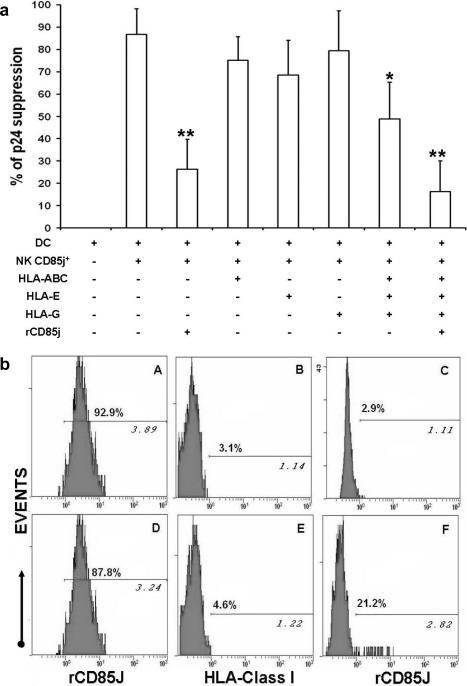
Involvement of NK CD85j receptor interaction with CD85j/ligands, including non-HLA class I ligands, in the control of HIV-1 replication in MDDC.(a) MDDC were infected with HIVBal and incubated with CD85j+ NK cells after blocking CD85j receptor interactions with HLA class I molecules on the MDDC by treatment with Mabs to HLA class I ABC (HLA-ABC), E (HLA-E) or G (HLA-G) or by incubating MDDC with a recombinant CD85j protein (rCD85j). Blocking reagents were also added during coculture. MDDC infection was evaluated by measuring p24 in the supernatants 10 days later. The results are expressed as the percentage suppression of p24 (mean+SE) in comparison with HIVBal-infected MDDC not exposed to NK cells in 8 independent experiments. Significant differences in the levels of p24 suppression after incubation with the three anti-HLA class I Abs, with rCD85j or with rCD8j more the three anti-HLA class I Abs in comparison to CD85j+ NK cells cultured with infected DC without Abs are indicated by asterisks: * p<0.05, **p<0.001 (b) Flow cytometric analysis of rCD85j binding to uninfected MDDC (top panels) or to HIVBal-infected MDDC (bottom panels). MDDC staining with rCD85j as revealed by anti-hIgG-PE Abs (A and D). MDDC staining with a mix of anti-HLA Class I-PE mAbs after incubation with rCD85j (B and E), or with rCD85j and anti-hIgG-PE Abs after incubation with a mix of anti-HLA Class I MAbs. A representative experiment of three is shown. Without rCD85j blockade, nearly all MDDC were stained by anti-HLA-PE (not shown). The concentrations of anti-HLA class I Abs used in blocking experiments (10 µg/ml of each anti-HLA class I A,B,C, E and G) totally prevented the detection of HLA class I molecules on MDDC by using labelled anti-HLA class I Abs (not shown). Percentages of positive cells and MFI (italic) are shown. Range of positive rCD85j cells was between 8.2 and 21.9.